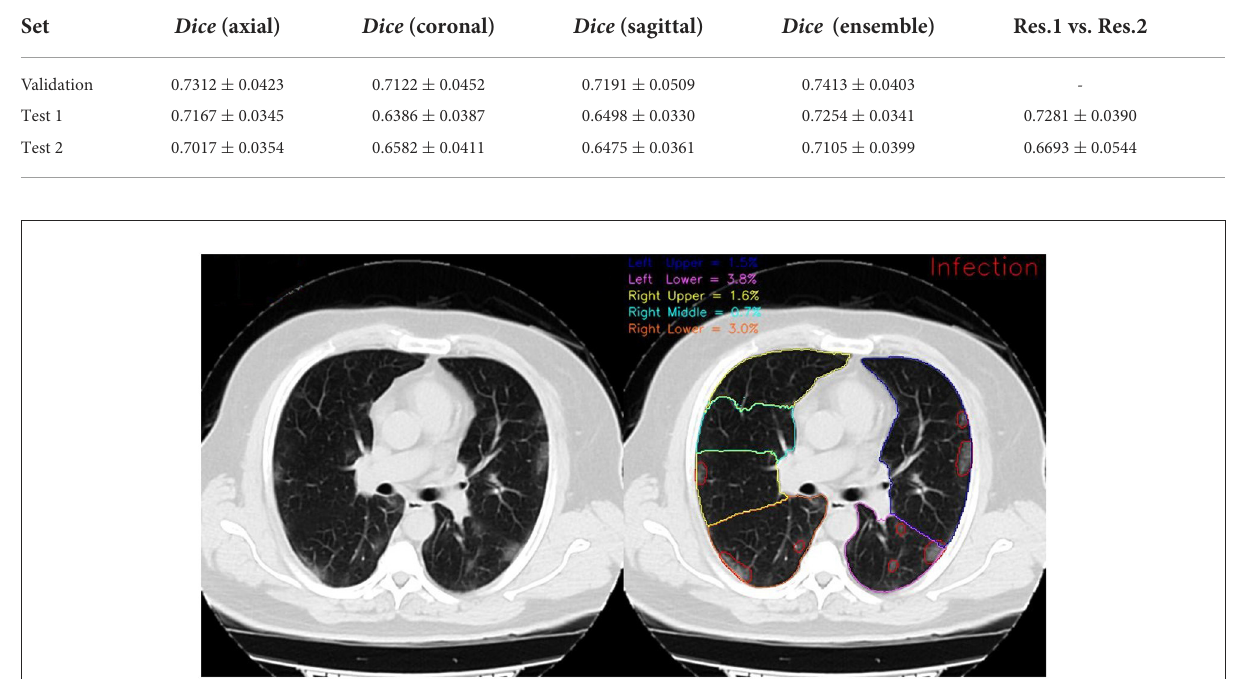
FIGURE4 Framework output for a COVID-19 diagnosed patient scan on the 72 nd slice of the axial view. On the left, red contours show the infection and on the right, different colored contours show distinct lung lobes. The reported infection severity percentages correspond to each lobe and are reported the same for each